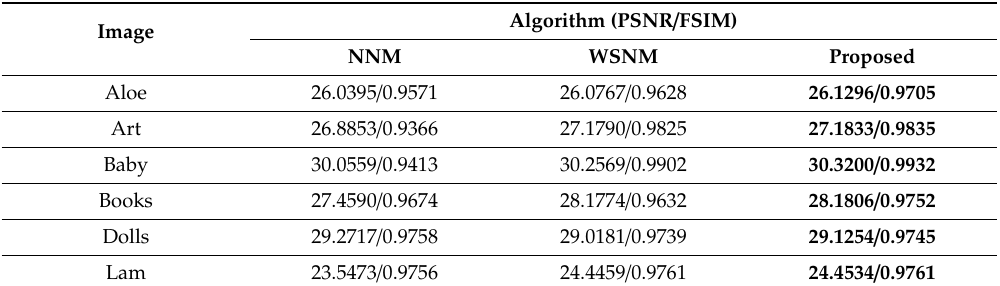
Table 2. Peak signal-to-noise ratio (PSNR) / feature similarity (FSIM) in experiment (1).